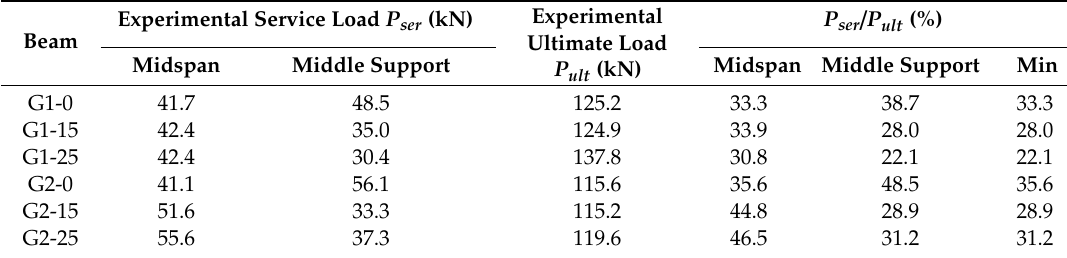
Table 6. Experimental service load for tested beams at which stress in the GFRP reinforcement reaches 20% of tensile